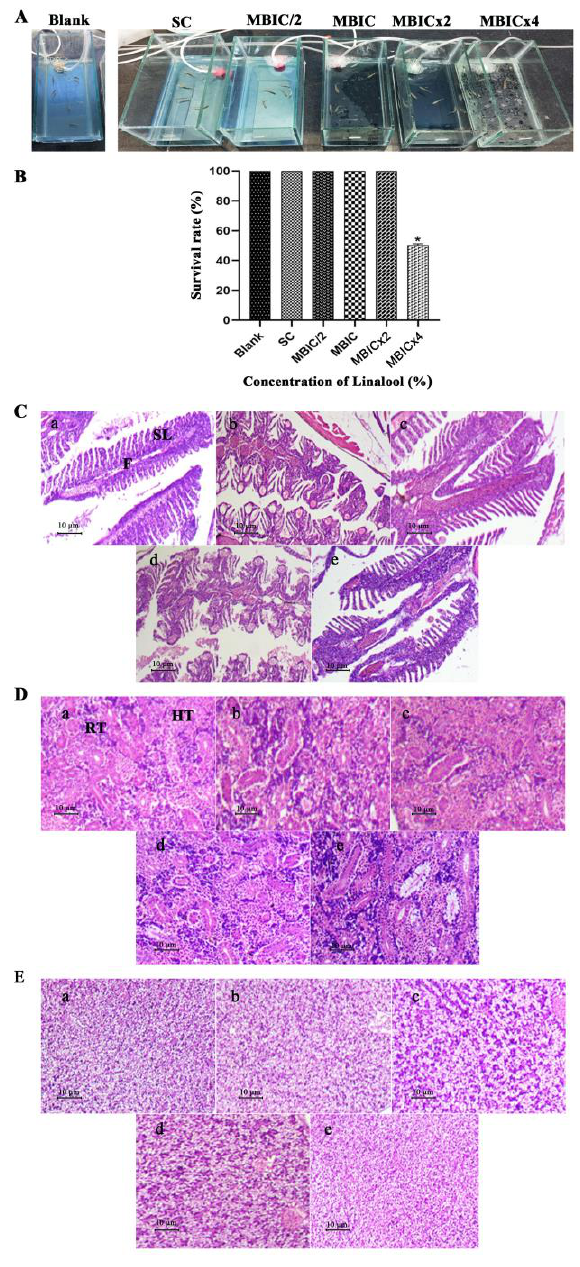
Figure 8. ( A ) Experimental setup for establishing an in vivo toxicity analysis on Danio rerio at different concentrations of Linalool. S.C. represents the solvent control. ( B ) In vivo study in Danio rerio . Survival percentage of Zebrafish at different concentrations of Linalool (%). Data are expressed as the mean ± S.D., p < 0.05. Blank is the control group, and S.C. is the solvent control. Linalool-treated histopathological samples of vital organs after the 4th day of treatment. ( C ) Light micrographs of gill morphology of adult zebrafish exposed to Linalool for 96 h (100 × ). ( a ) Control group; ( b ) solvent control exhibiting normal structure, including a gill arch formed by filaments (F) and lamellae (S.L.); ( c – e ) gills exposed to MBIC/2, MBIC, and MBIC × 2 of Linalool exhibited normal histology. ( D ) Light micrographs of the kidneys of adult zebrafish exposed to Linalool for 96 h (100 × ). ( a ) Control group; ( b ) solvent control exhibiting normal histology with regular renal tubules (R.T.); ( c – e ) kidney from fish exposed to MBIC/2, MBIC, MBIC×2 exhibiting normal histology. ( E ) Light micrographs of liver of adult zebrafish exposed to Linalool for 96 h (100×). ( a ) Control group ( b ) solvent control exhibiting normal structure with normal hepatocytes (H); ( c – e ) liver from fish exposed to MBIC/2, MBIC, and MBIC×2 exhibited normal histology.